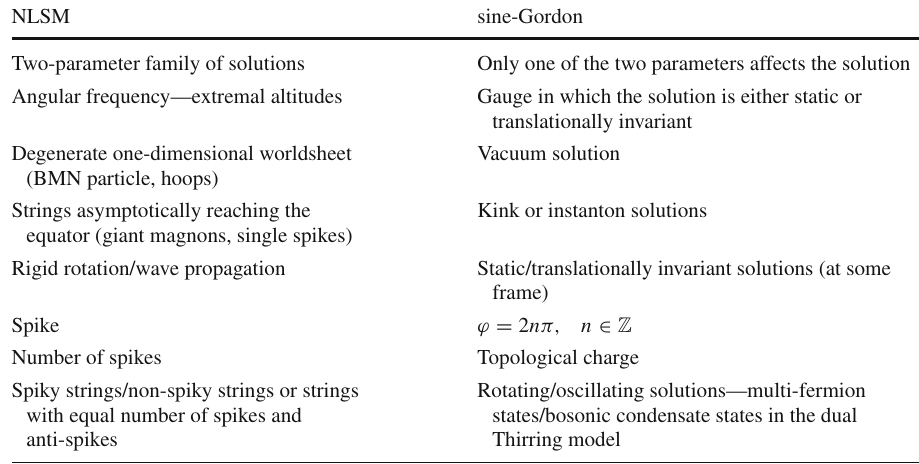
translationally invariant